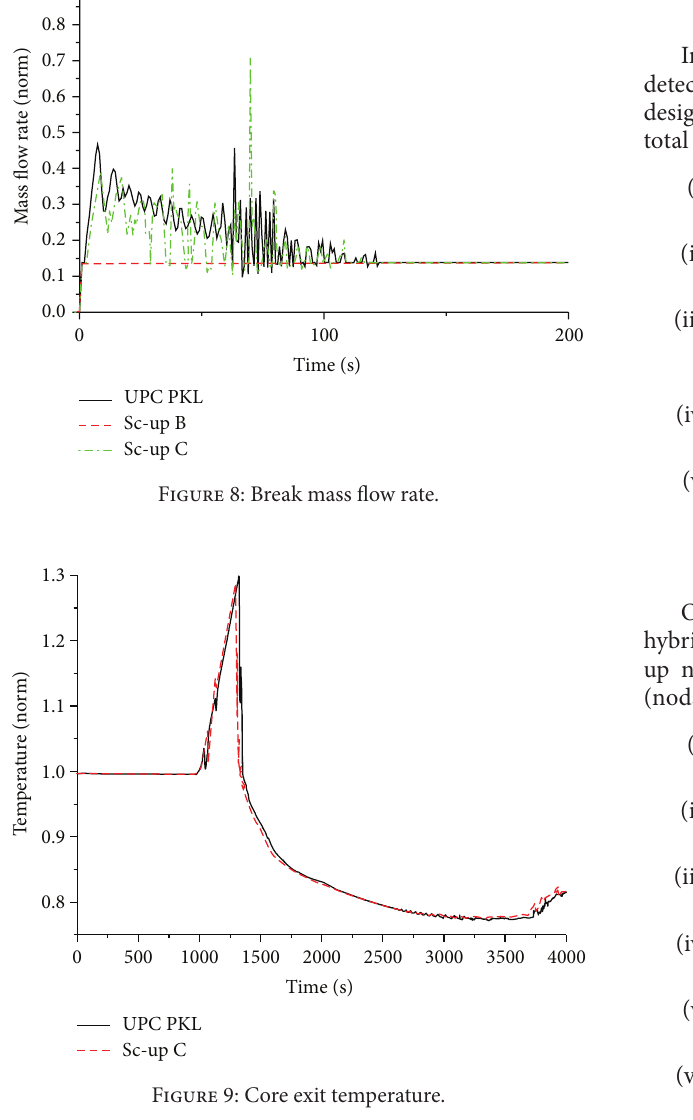
Figure 8: Break mass flow rate.